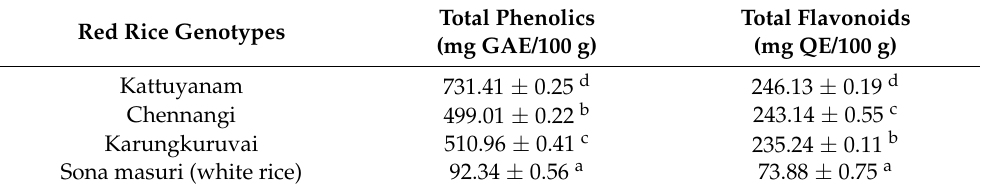
Table 3. Total phenolics and total flavonoid contents of the red rice